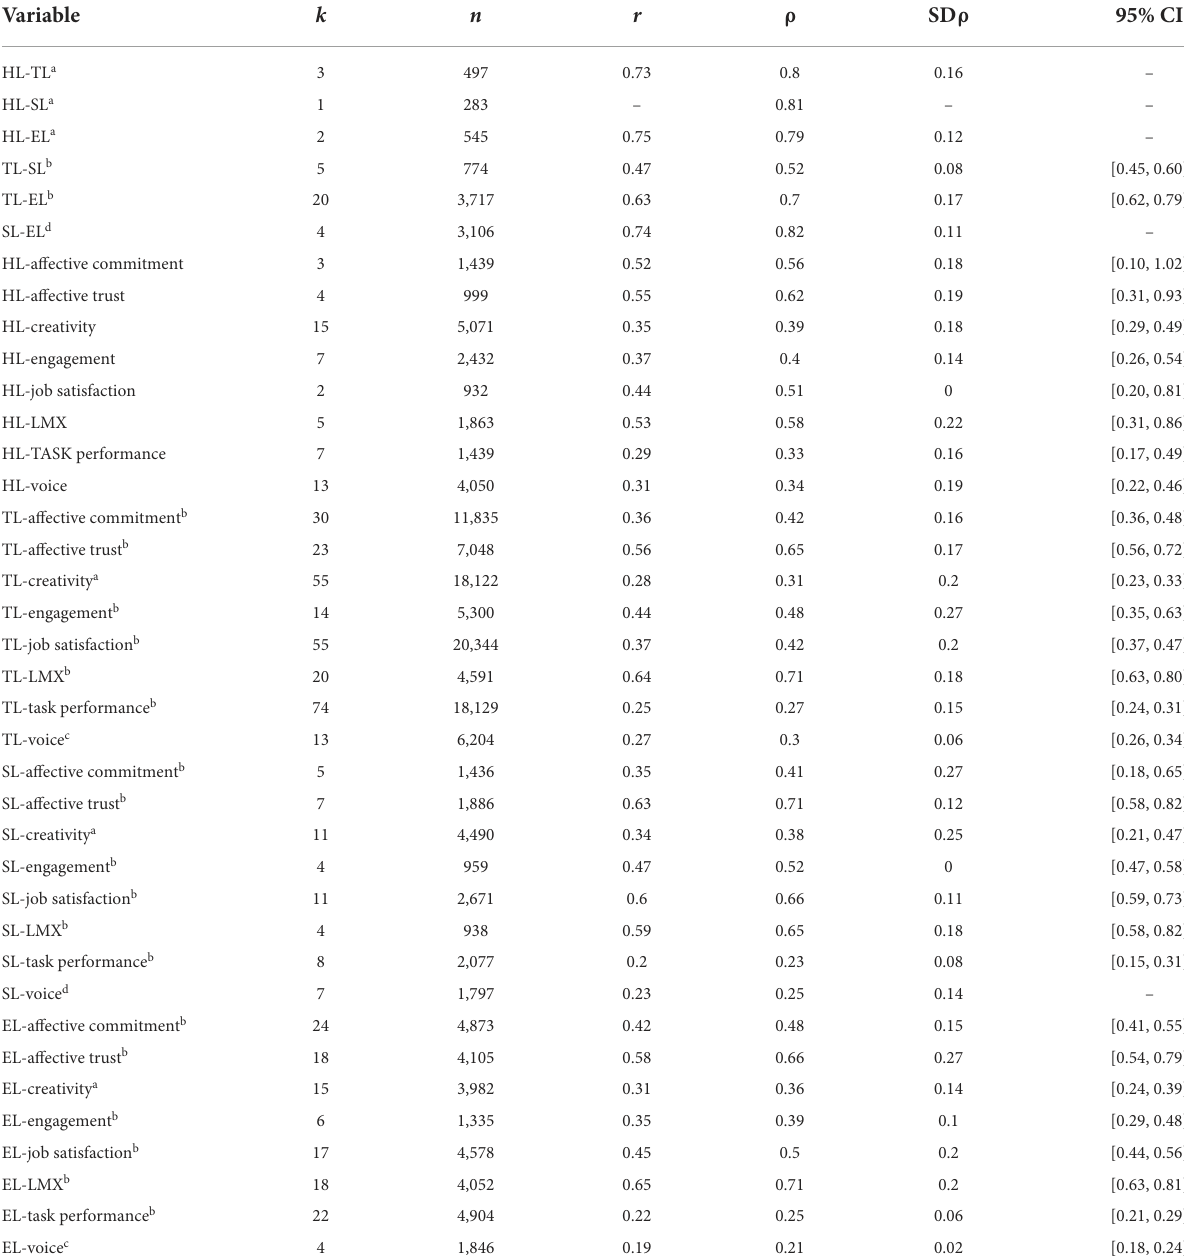
TABLE 5 Meta-analytic correlation required for incremental